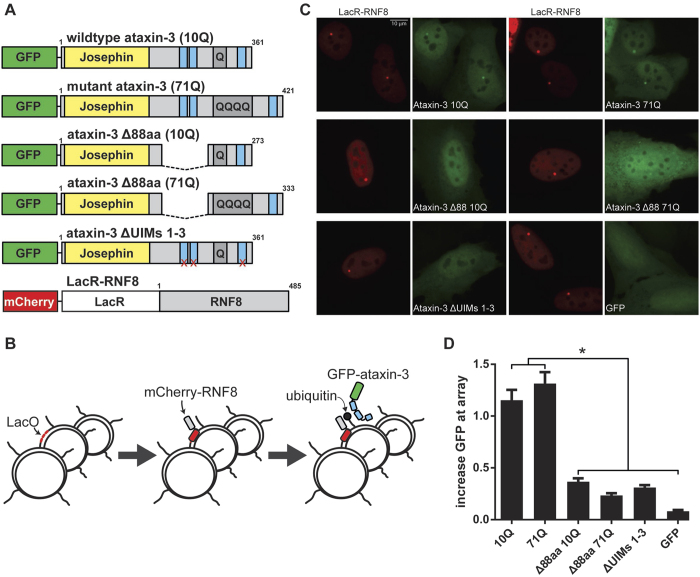
Modified ataxin-3 shows reduced binding of ubiquitin chains.(A) Schematic representation of ataxin-3 GFP-tagged proteins used for assessment of ubiquitin-binding with relevant functional domains depicted (not drawn to scale). For ataxin-3 ΔUIMs 1-3, the three UIMs were inactivated by point mutations. RFN8 ubiquitin ligase contained an N-terminal mCherry-LacR tag to enable visualization and targeting to the LacO array. (B) Representation of the histone ubiquitylation approach. A lacO repeat integrated into the genome of 2-6-3 U2OS cells allows targeting of the LacR-RNF8 fusion protein to the genomic LacO array, leading to localized chromatin ubiquitylation, which is bound by Ataxin-3. (C) Representative fluorescent images from transfected 2-6-3 U2OS cells expressing mCherry-LacR-RNF8 (red) and GFP-tagged Ataxin-3 proteins (green). Scale bar 10 μm (D) Quantification of ataxin-3 localisation at the LacO repeat. Increase in GFP signal at the site of mCherry signal signifies association of ataxin-3 with ubiquitin chains. Displayed values are the mean of 2 independent experiments in more than 50 cells per condition. *P ≤ 0.0001, bars depict mean and SE.